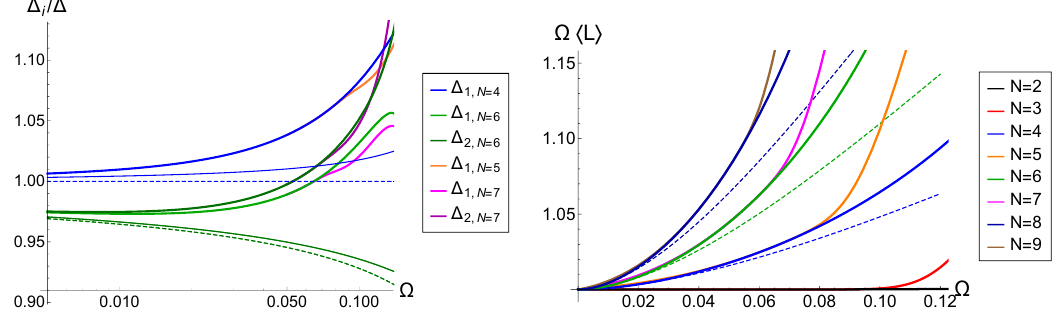
(cid:0) (cid:1) Ω 2 , ∆ 0 is shown as